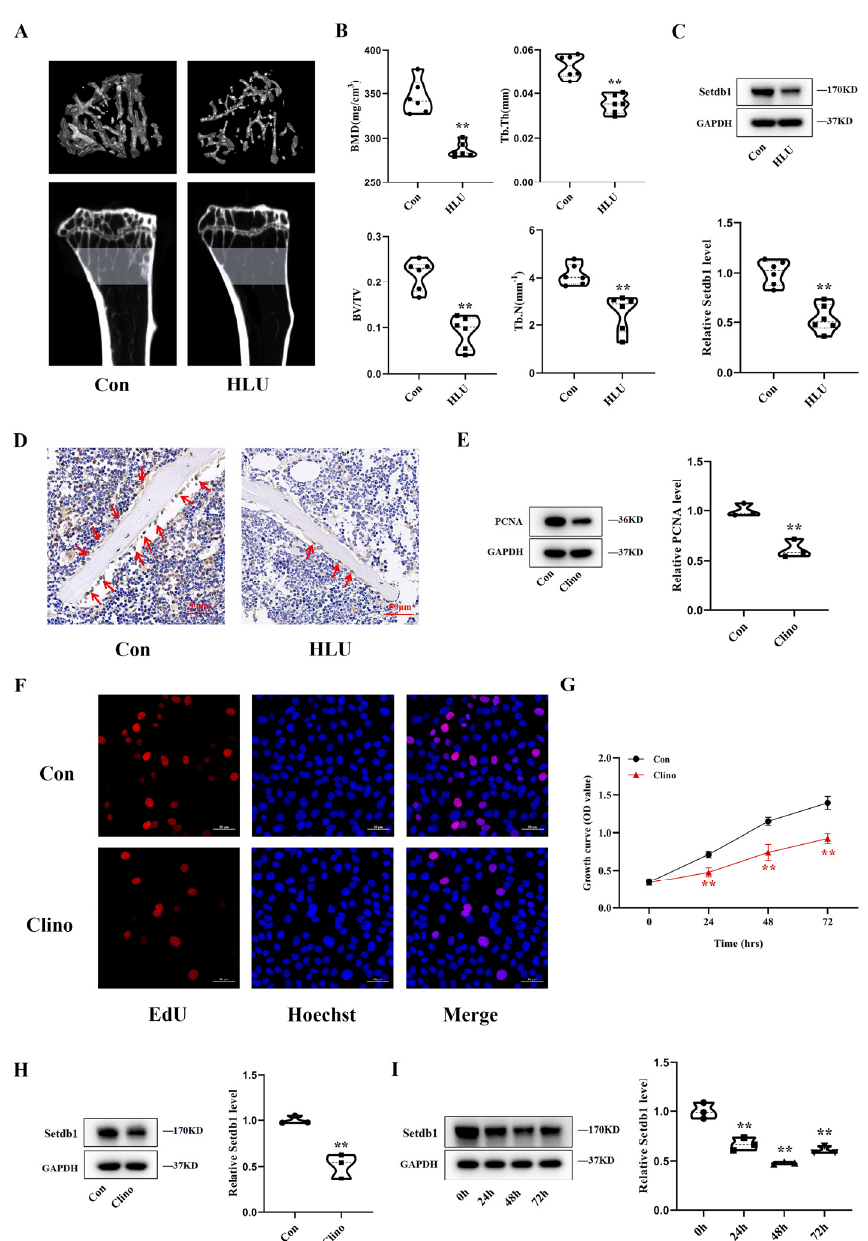
Figure 1. Setdb1 is downregulated in vivo and in vitro under mechanical unloading. ( A ) Representative images of micro-CT and three-dimension reconstruction for proximal tibias of mice in the Con and HLU group ( n = 6). ( B ) The three-dimensional measurement of the bone mineral density (BMD), trabecular thickness (Tb. Th), trabecular number (Tb. N), and bone volume to total volume (BV/TV) in the ROI region of the proximal tibias of mice ( n = 6). Student’s two-sided t -test. ( C ) The protein level of Setdb1 in bone tissues from each group ( n = 6). Student’s two-sided t -test. ( D ) Representative images of Setdb1 immunohistochemical staining in the tibias of mice from each group ( n = 6). Scale bar, 50 µ m. ( E ) Western blotting analysis of PCNA protein levels in MC3T3-E1 cells ( n = 3). Student’s two-sided t -test. ( F ) The EdU labeling assays of MC3T3-E1 cells in the Con and Clino group ( n = 3). Scale bar, 50 µ m. ( G ) Cell proliferation assessed by the CCK-8 assays from the Con and Clino group ( n = 3). Repeated measures ANOVA. ( H ) Western blotting analysis of Setdb1 protein level in 48 h under clinorotation unloading ( n = 3). Student’s two-sided t -test. ( I ) The changes in the Setdb1 protein level analyzed by Western blotting under clinorotation unloading for 24, 48, and 72h ( n = 3). One-way ANOVA was followed by LSD’s multiple comparisons test. ** p < 0.01 vs. the cells at 0